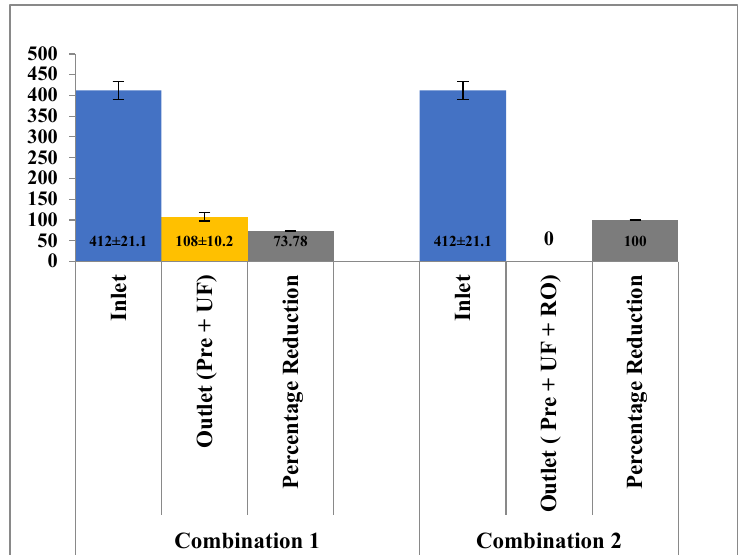
7 of 12 Figure 7. Effect of different treatment setups on the BOD rejection .